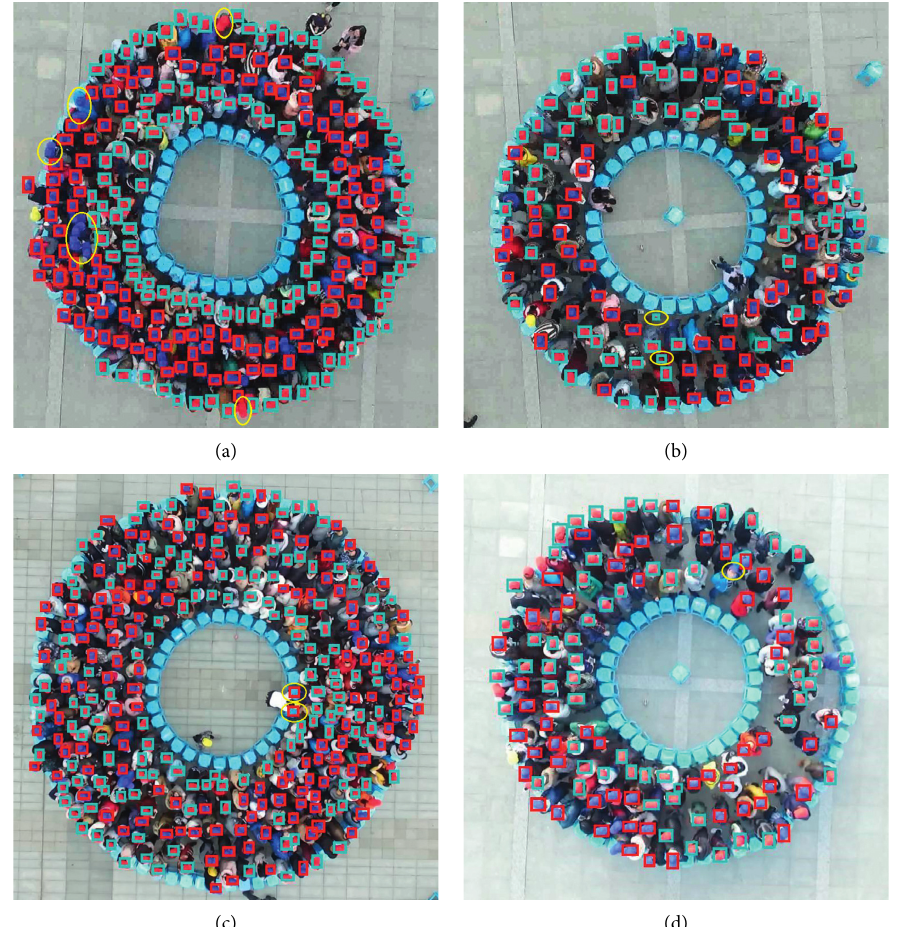
Figure 6: Some typical errors in the detection results. (a) Some caps are not detected due to the very high densities, in 16-9-1; (b) some clothes (or shoes) are recognized as caps due to the similar colors, in 16-5-1; (c) some stools are occasionally recognized as blue caps, in 17-6- 1; (d) one cap is not detected, since the pedestrian rises his head at this moment, in 16-5-2.